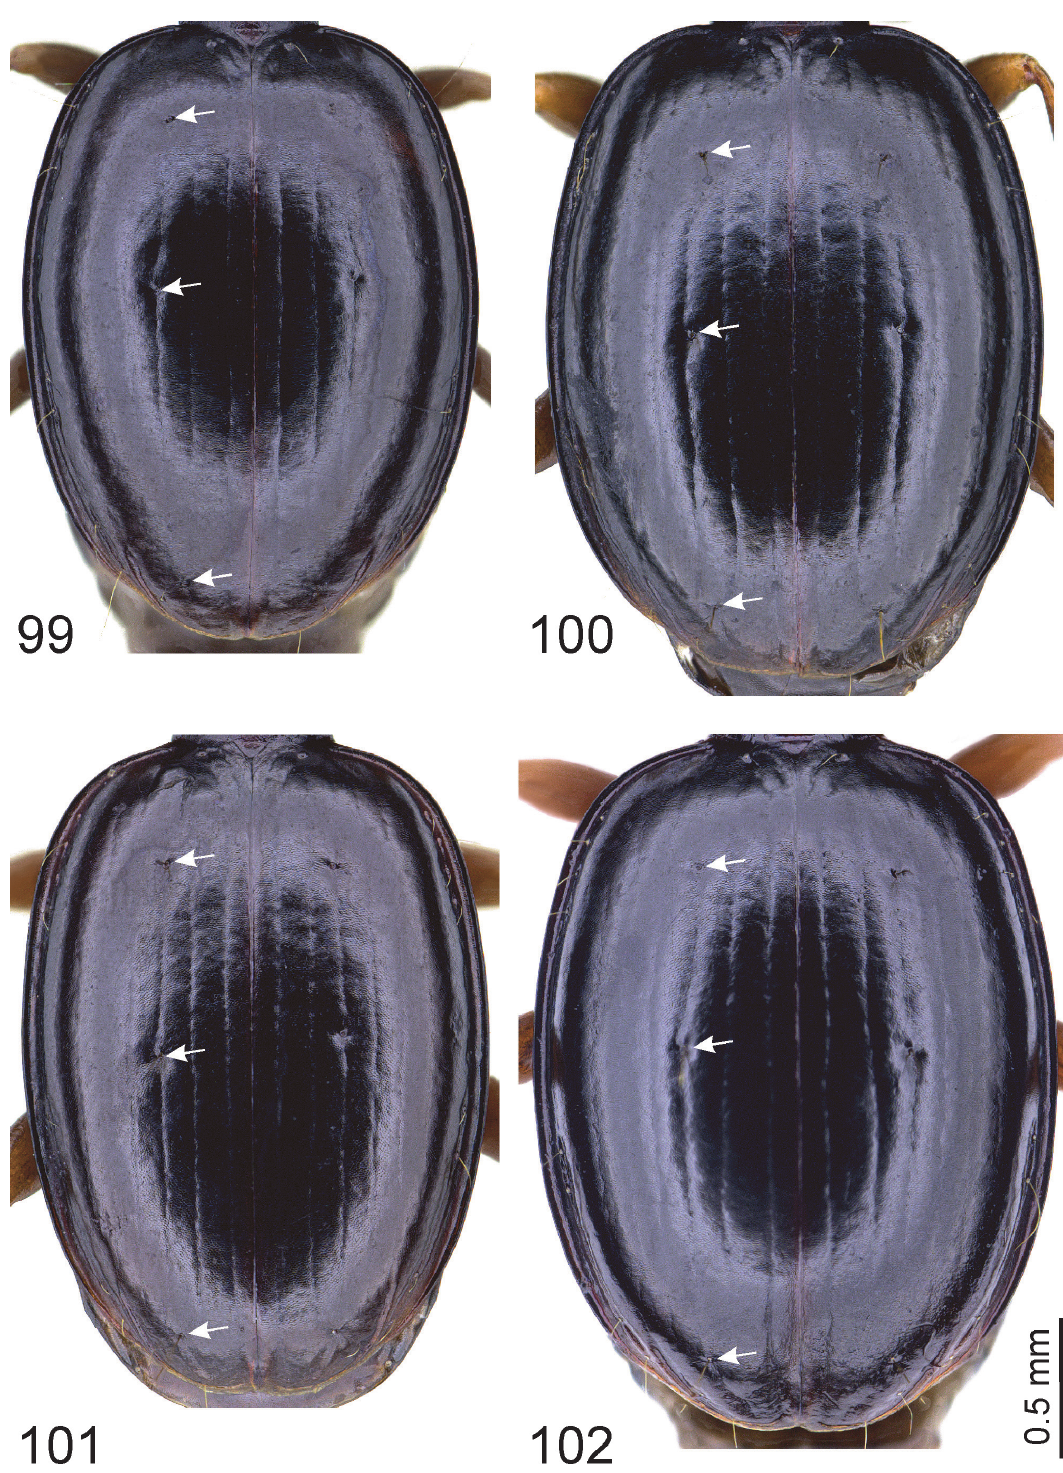
Figs 99–102. Trechus spp., elytra. 99 . T. fisehai sp. nov., paratype, ♂. 100 . T. angavoensis sp. nov., holotype. 101 . T. batuensis Magrini & Sciaky, 2006, ♂ from Sanetti Plateau near Tulo Dimptu. 102 . T. batuensis , ♂ from Tegona Valley. The arrows point to the insertions of the discal setae and the preapical